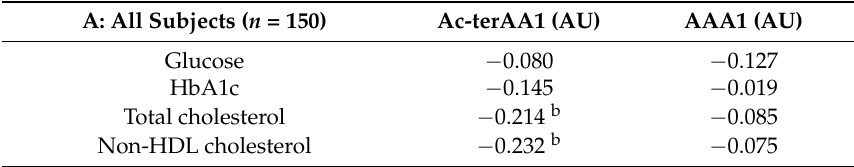
Table 2. Associations of Ac-terAA1 and AAA1, expressed as arbitrary units (AU), with plasma lipids, (apo)lipoproteins, pre- β -HDL, phospholipid transfer protein (PLTP) activity, lecithin–cholesterol acylesterase (LCAT) activity, cholesterol esterification (EST), cholesteryl ester transfer protein (CETP) mass, cholesteryl ester transfer (CET) and cholesterol efflux capacity (CEC) in all subjects combined ( A ) and separately in 75 control subjects ( B ) and in 75 Type 2 diabetic patients ( C